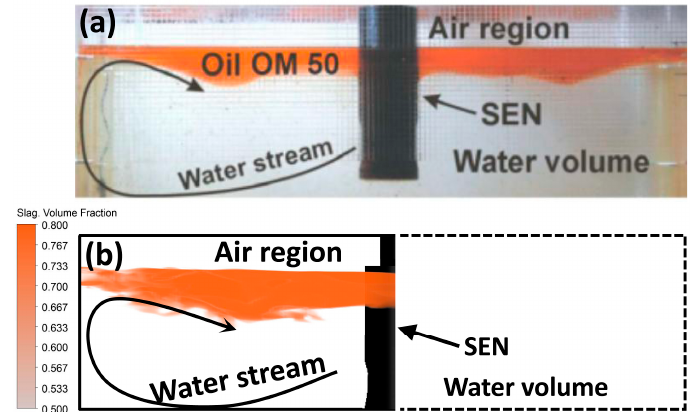
Figure 4. The morphology of the slag layer: ( a ) experimental observation [13], and ( b ) predicted result.